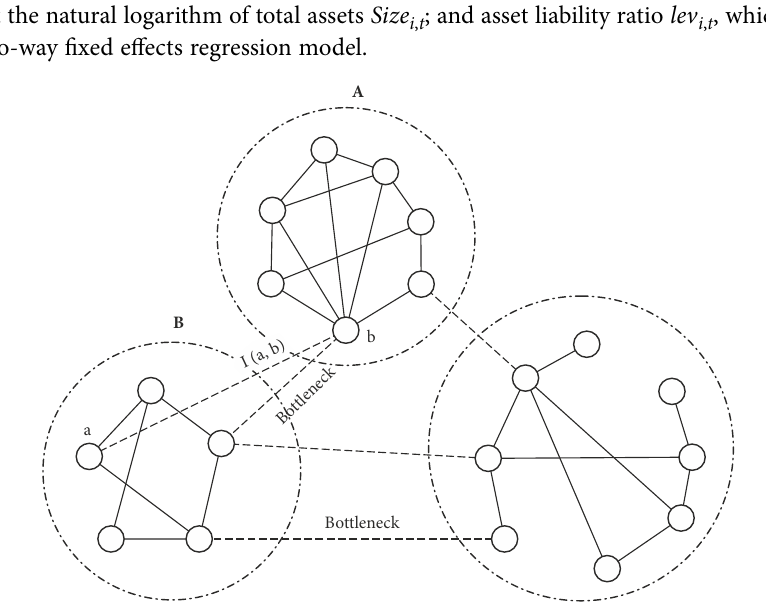
Figure 4. Example of GN algorithm